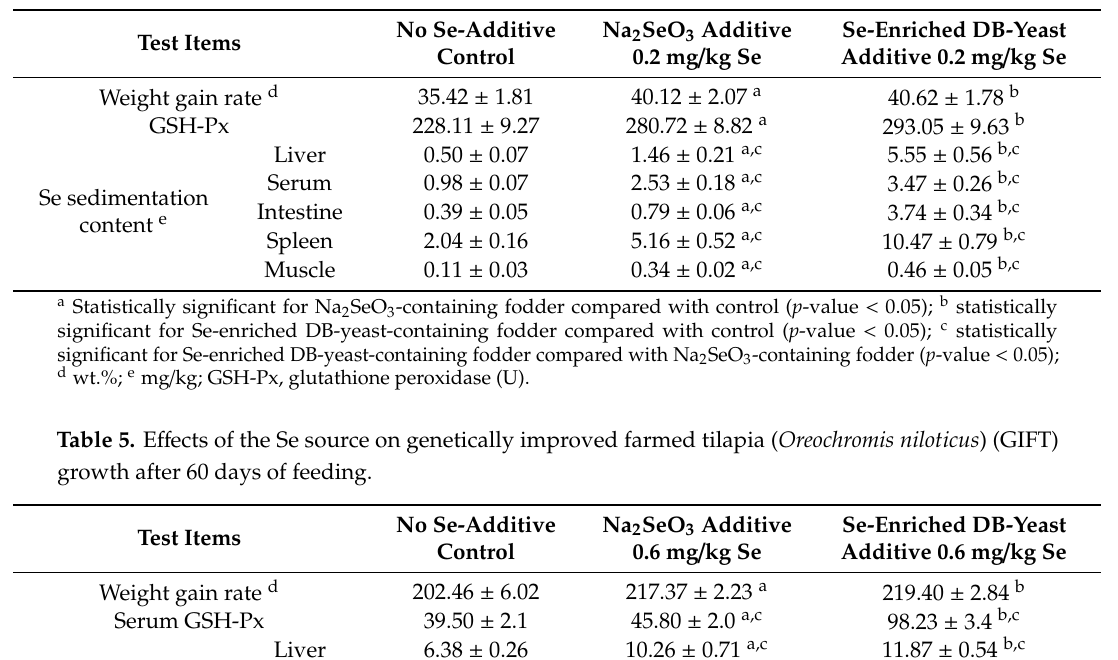
Table 4. E ff ects of the Se source on mouse growth after 21 days of feeding.